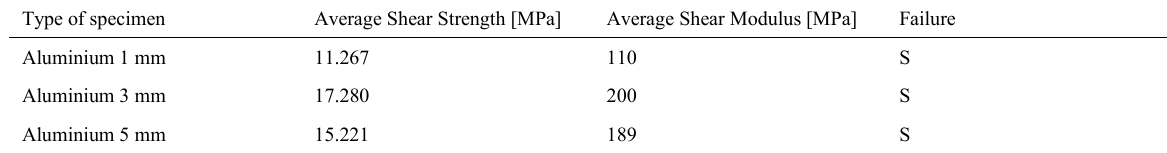
Table 1: Reference set of specimens with